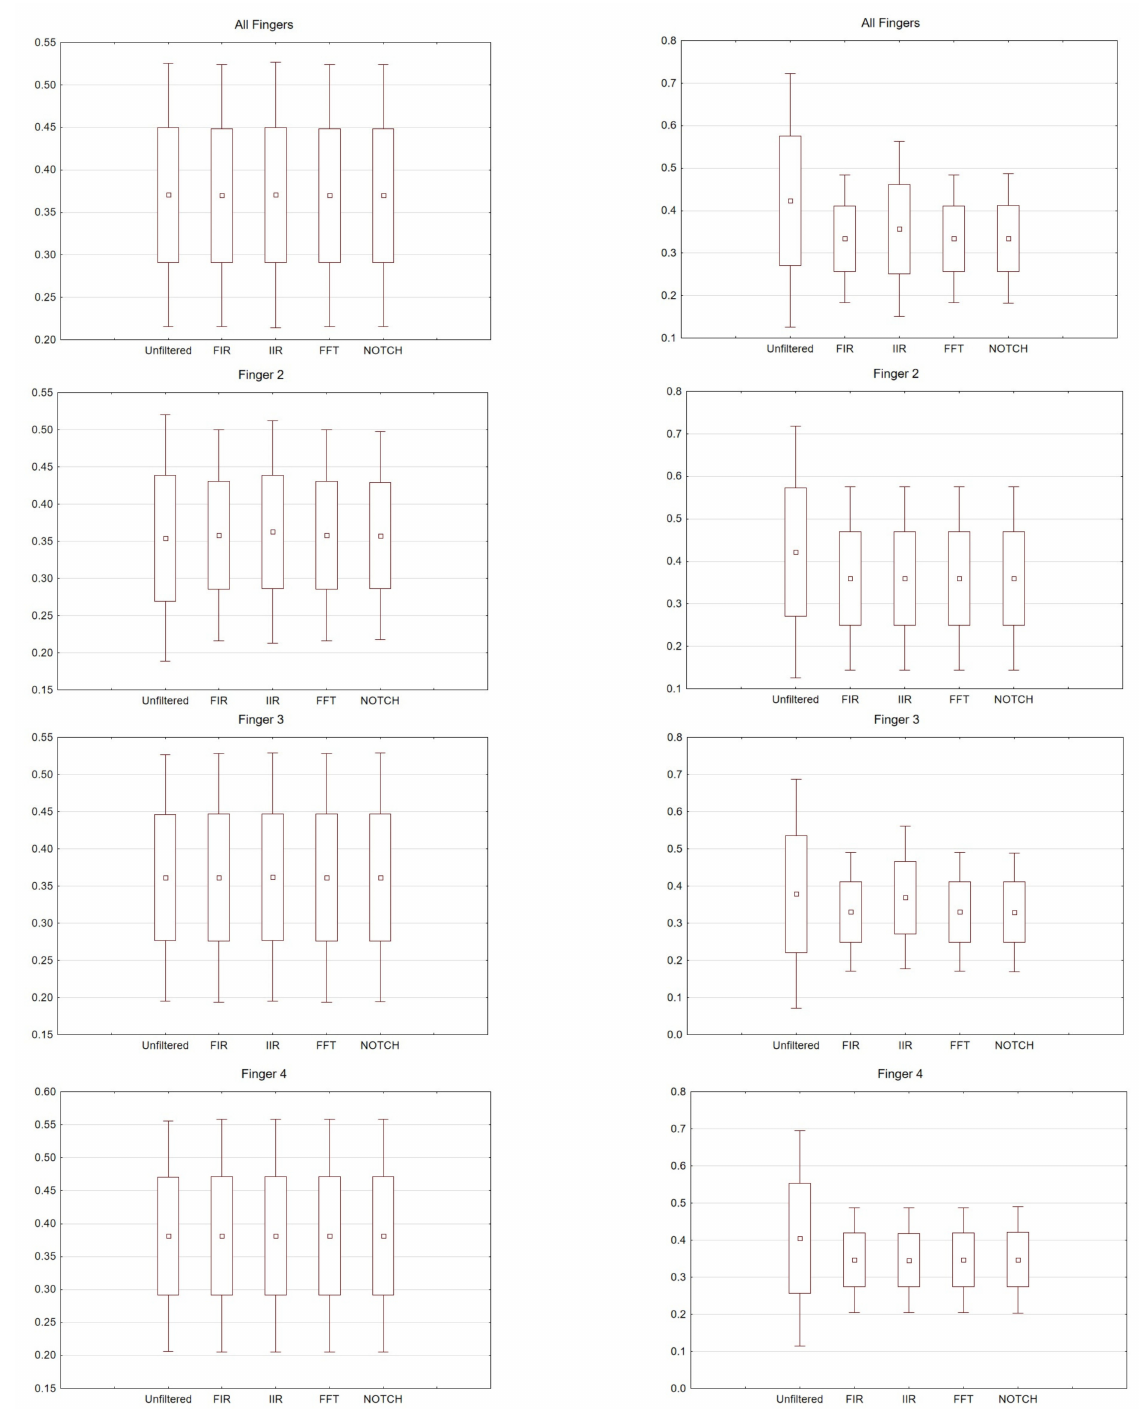
Figure 6. Box and whisker plot depicting latency values for averaged values, fingers 2, 3 and 4. From the left: Right hand and left